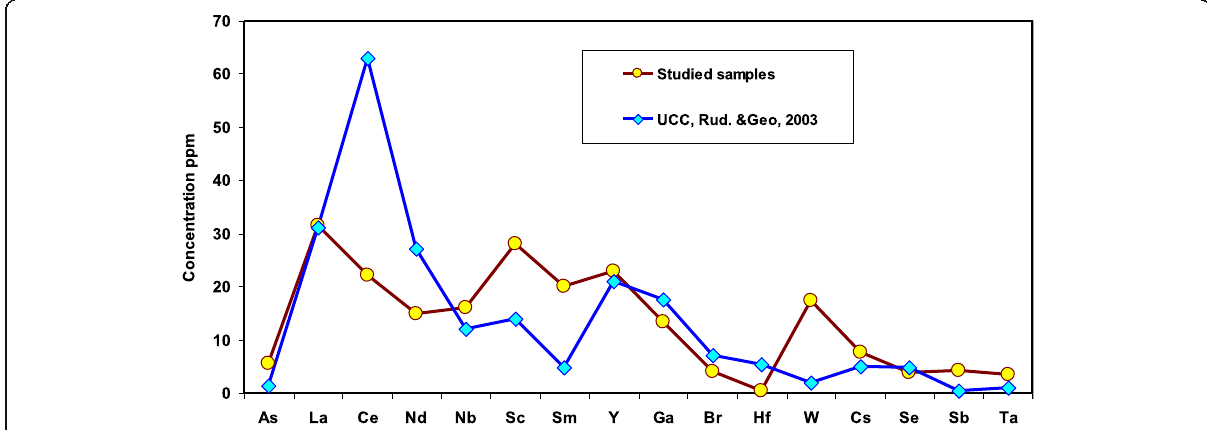
Fig. 4 The concentration of the rare earth elements of the studied carbonate rocks compared with the UCC (Rudnick and Gao